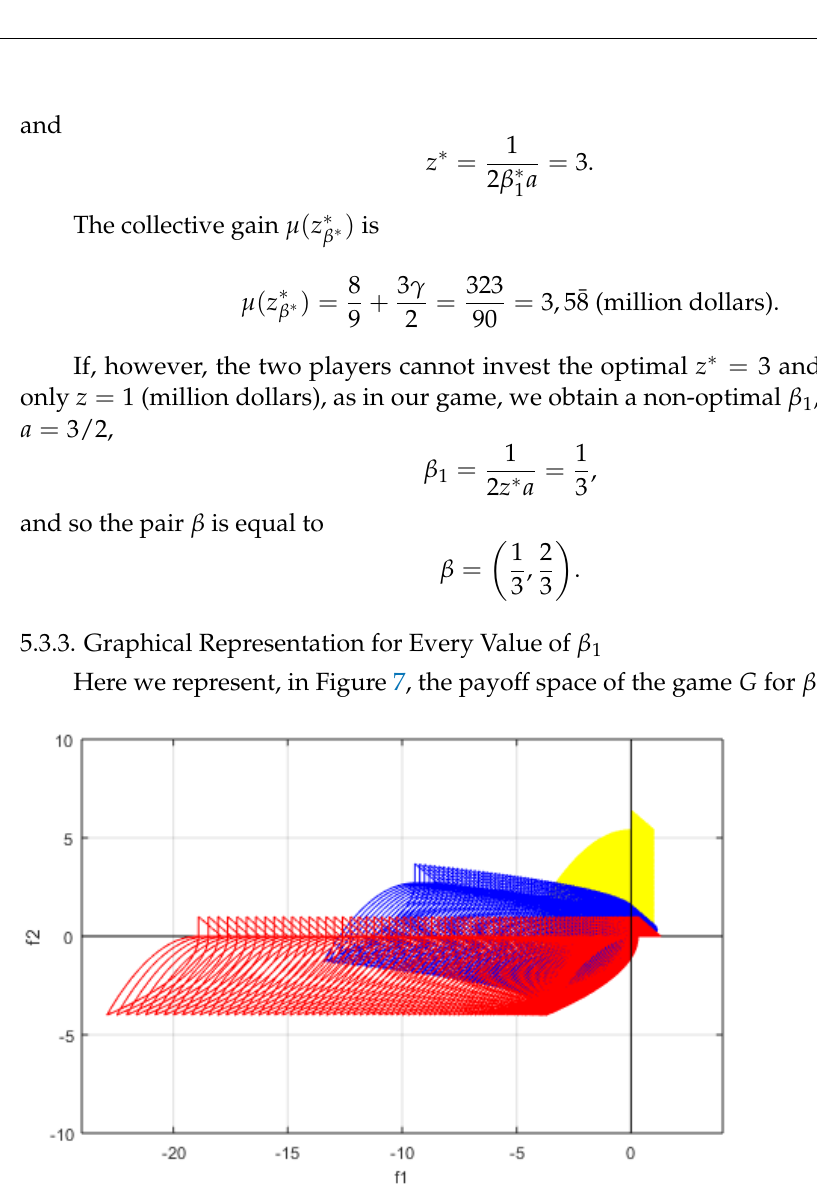
Figure 7. Payoff spaces for three values of β 1 and z ∈ [ 0,3 ] .